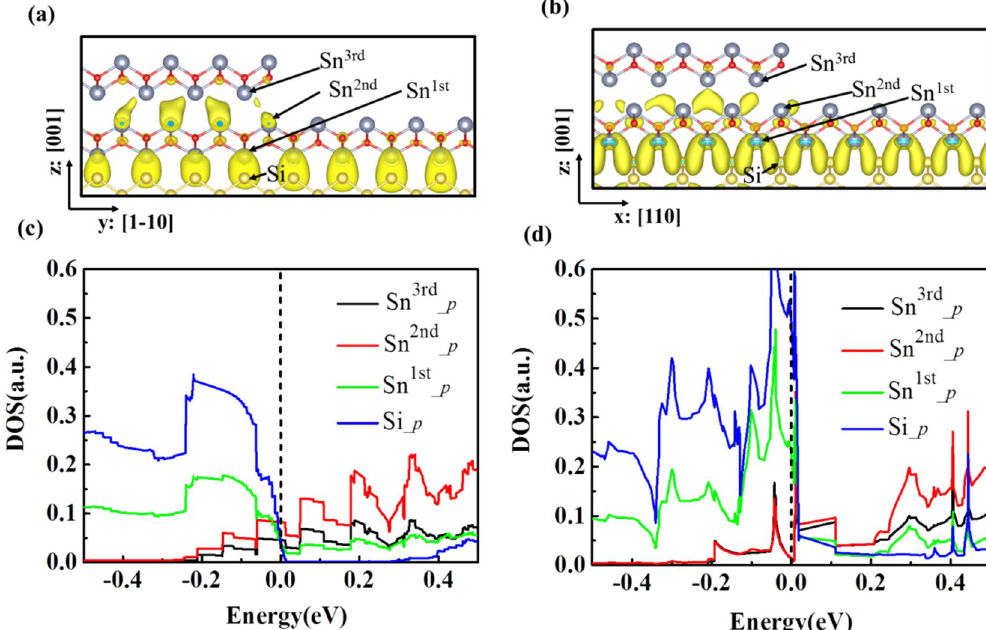
Figure 5. Contour plots of the charge density at the interface of BL and ML SnO/Si(001) along x:[110] direction ( a ) and y:[1–10] direction ( b ) with an “edge up” configuration associated with states in the energy range: E F − 0.1 < E < E F + 0.1 eV. ( c ) and ( d ) are the density of states projected on interfacial atoms shown ( a ) and ( b ), respectively.